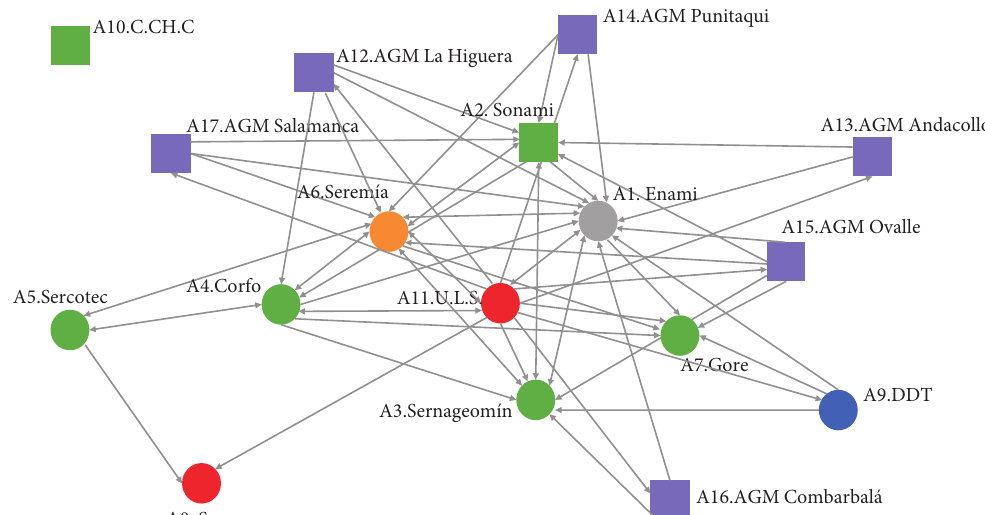
Figure 2: The social network of actors linked to the problem of the mineral extraction process of small mining companies in the Coquimbo Region, Chile (UCINET ® ) (circles: public actors; squares: private organizations or associations; grey: ENAMI; green: promoting; red: training; blue: control, orange: technical support; purple: association.